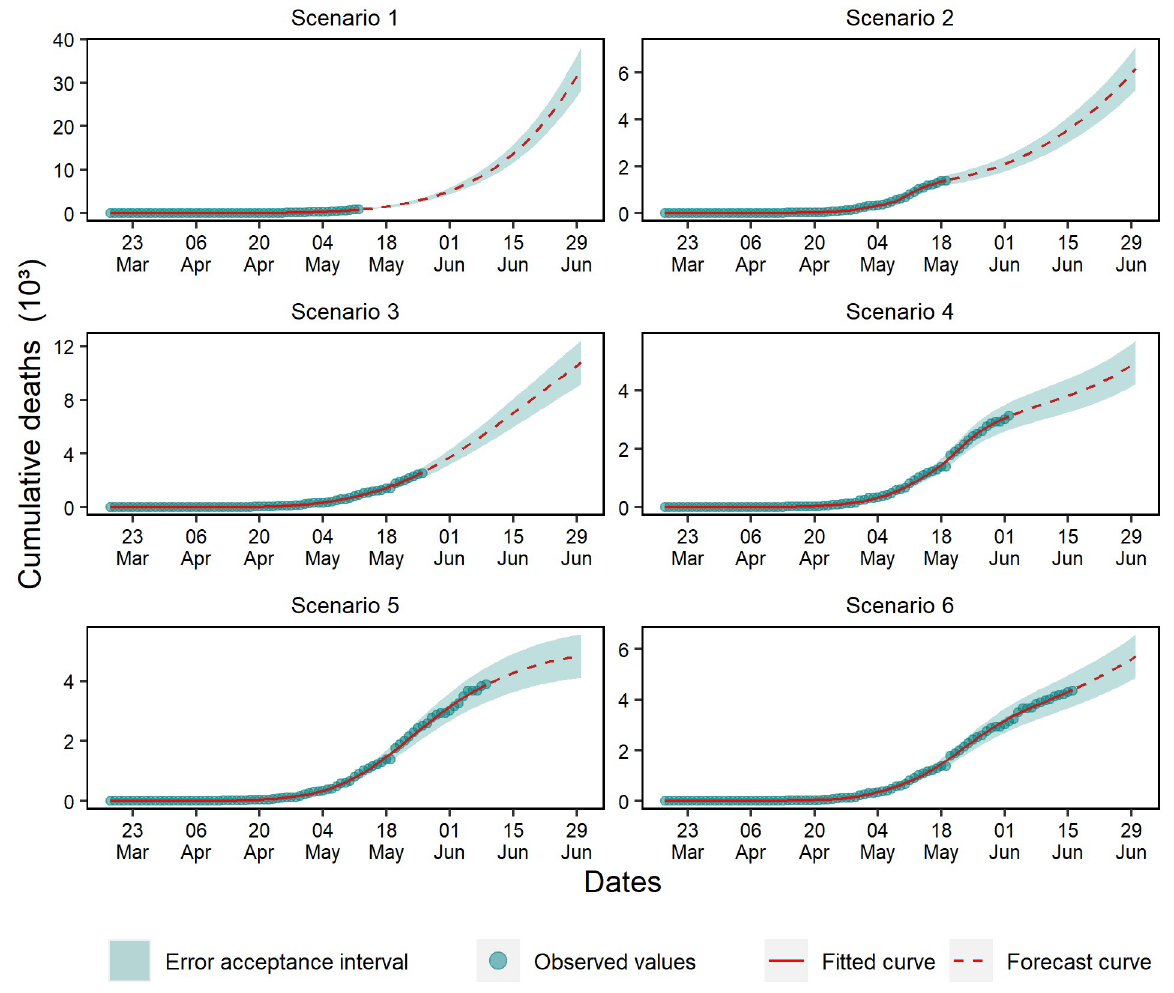
Fig 5. Forecasting of cumulative deaths in the six analyzed